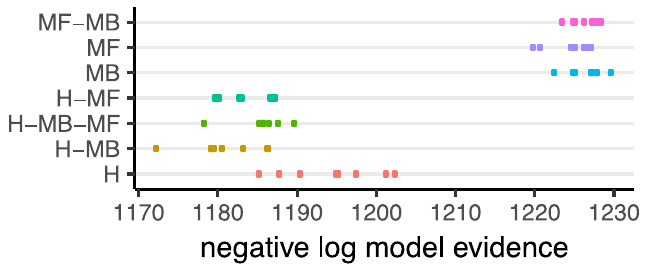
Fig 4. Negative log model-evidence ( − log p ( D | M );lower numbers indicate better models) for the first best eight models in each family of computational models. Different models are shown on the y-axis using different colours for better